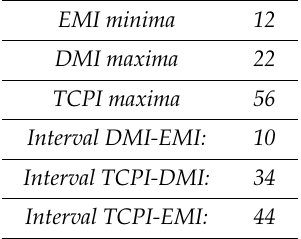
Table 13. Minima in the EMI (Figure 12) and the corresponding local maxima in the DMI followed by a dip in the